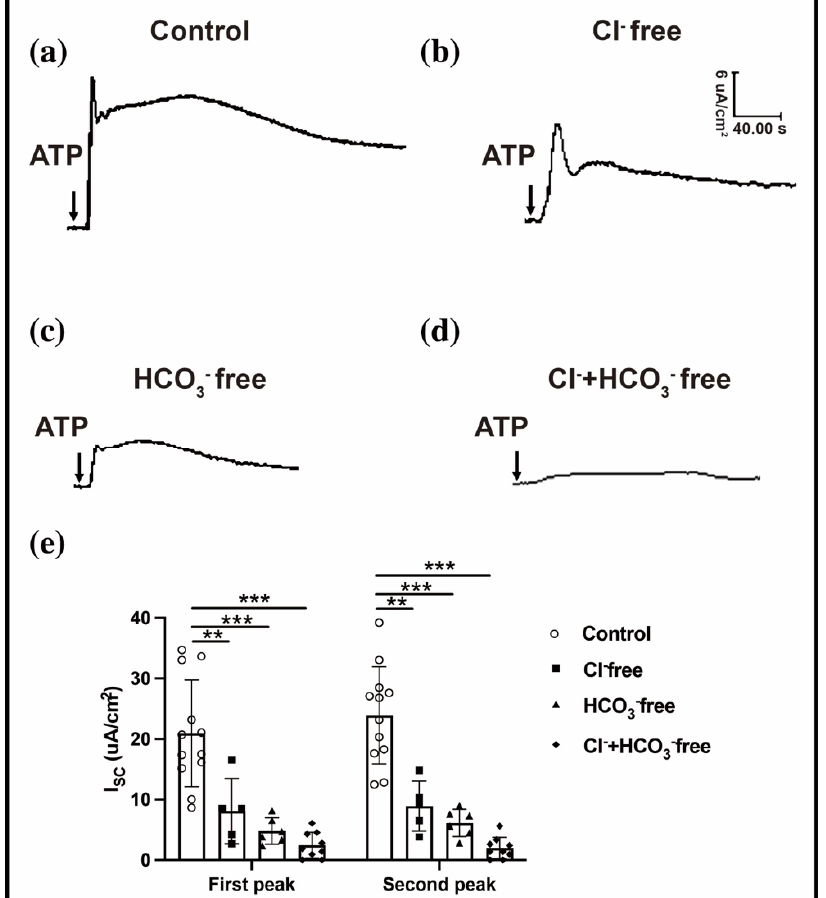
Figure 4. ATP-induced conjunctival Isc related to Cl – channel. ( a – d ) Representative image of ATP- induced conjunctival Isc in the control group ( a ), Cl – -free group ( b ), HCO 3– -free group ( c ), and both Cl – -free and HCO 3– -free groups ( d ). ( e ) Bar graph showing the first peak and second peaks of ATP- induced conjunctival Isc in the control (n = 12), Cl – -free (n = 5), HCO 3– -free (n = 6), and both Cl – -free and HCO 3– -free groups (n = 9). Data are represented as mean ± SEM. All data were compared with the control group. ** p < 0.01, *** p <